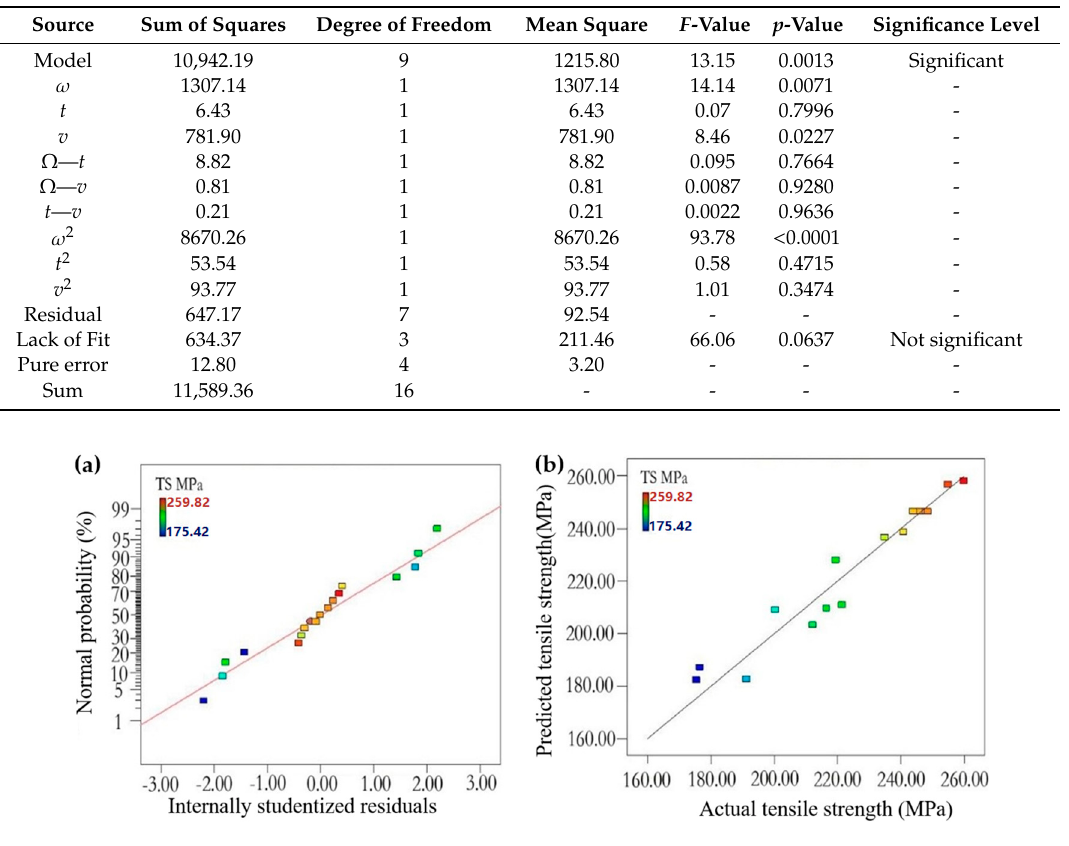
Figure 3. ( a ) Normal plots of response residuals for tensile strength (TS) and ( b ) actual vs. predicted values of the response for TS.